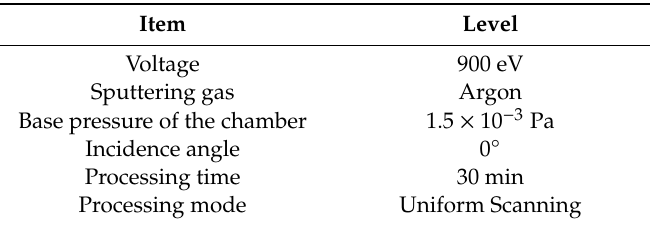
Table 8. Parameters of Combined Process (#4).